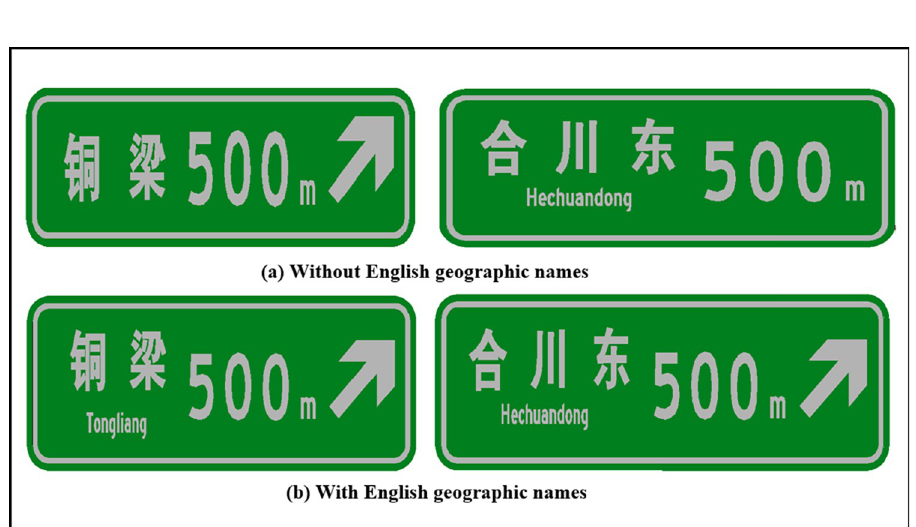
Fig 10. Sample layout of exit advance guide signs in